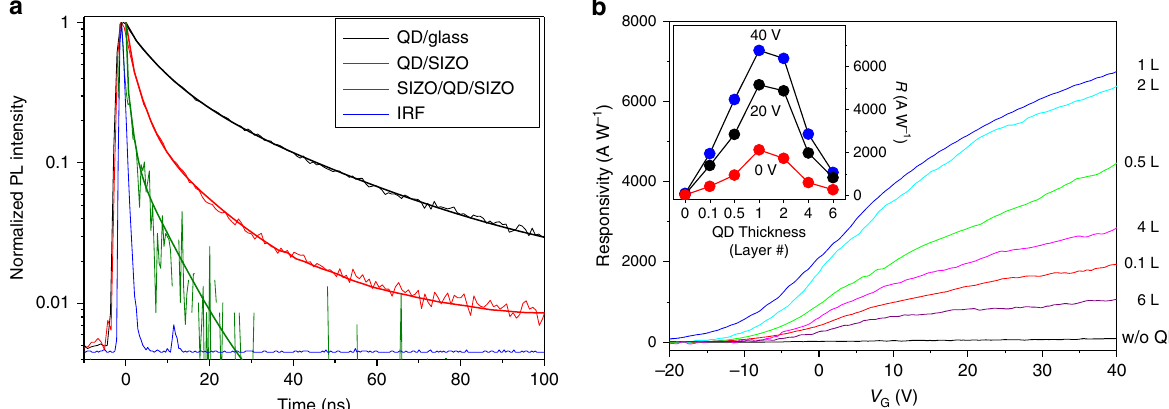
Fig. 3 Measurement results of fl uorescence decays and photoresponses. a Fluorescence decay curves of three different monolayered-red-QD fi lms, i.e., QDs, QDs on SIZO, and SIZO/QD/SIZO (OQO), all on glass substrates. The blue line is the system instrumental response function (IRF). The thicker solid lines are the fi tting of each decay curves . b R vs. V G with respect to QD layer thickness for red-QD OQO phototransistors. The incident light at 487-nm wavelength is illuminated with 10-nW power. In all, 0.1 and 0.5 L correspond to areal coverage of 10% and 50% of the monolayered-QD fi lms, respectively. The inset fi gure shows the R values vs. the QD layer thickness